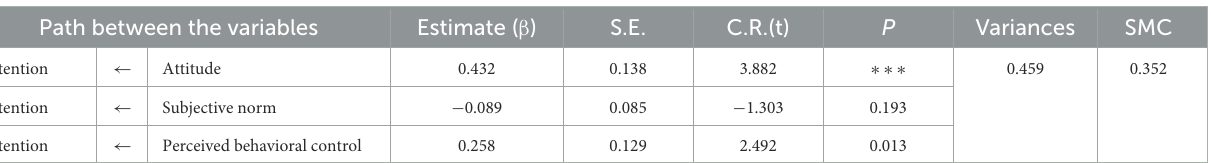
TABLE 5 Analysis of path analysis model.